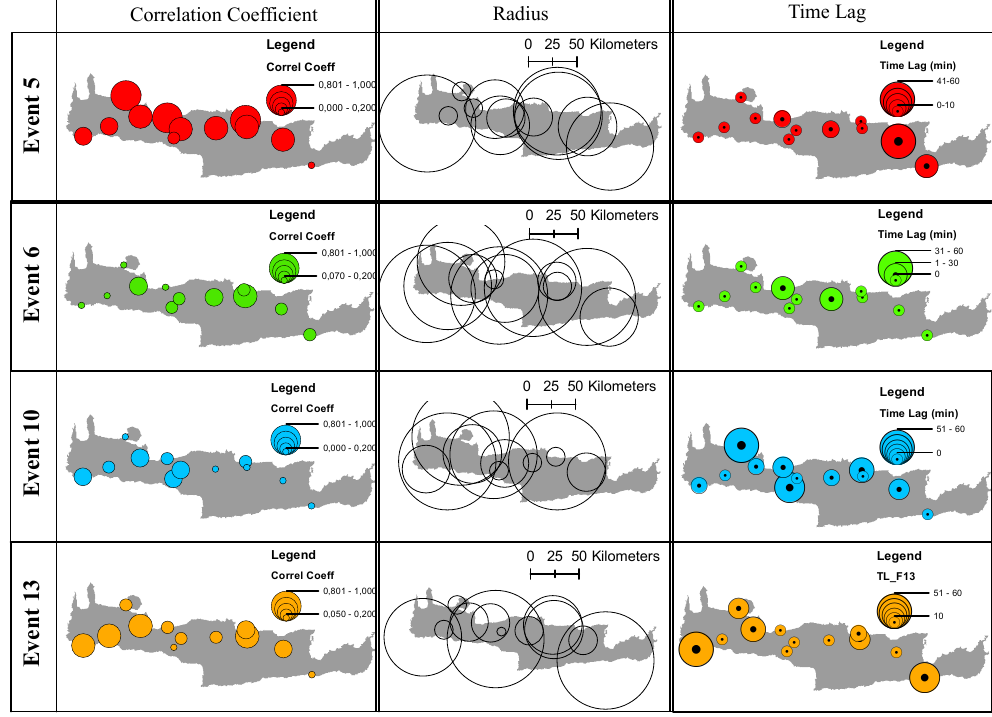
Fig. 6. Maximum attained coefficient of determination (1st column) at specific radius (2nd column) and time lag (3rd column) per station for the four flood